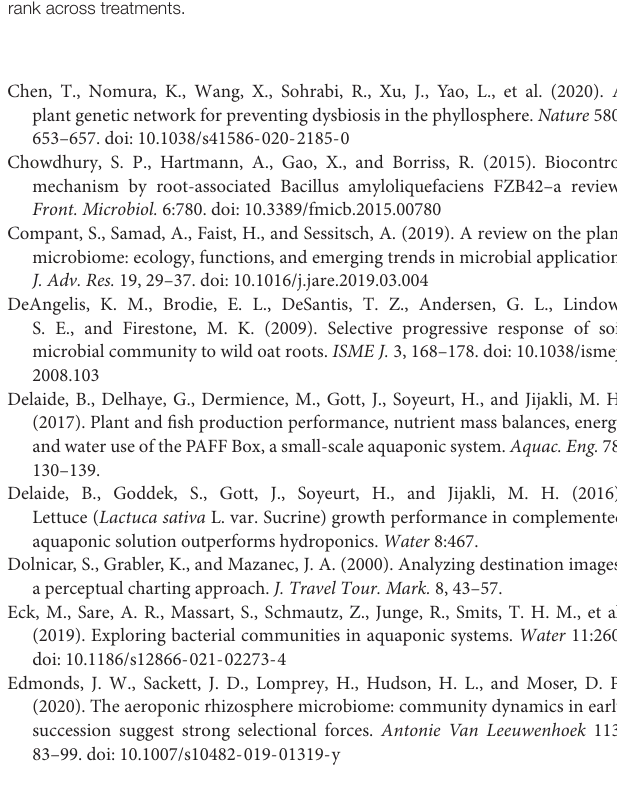
Supplementary Figure 1 | Cluster dendrogram of the distribution of microbial communities at the order rank across treatments with the five most robust clades highlighted. Similar patterns were observed at higher ranks. Treatments include hydroponic nutrient solution sump (HNS) and biofilter effluent sump (BF) under mature (.m), sterilized (.s), and basin water column (.aqueous) conditions. Additionally, soil inoculum (Soil) and HNS inoculated culture (soil) and probiotic (probio) inoculated sterilized (.s) and unsterilized biofilter effluent (BF) samples, as well as the facility water source (WS) and recirculating aquaculture system water column (RAS) are also included. Supplementary Figure 2 | Cluster dendrogram of the distribution of microbial communities at the family rank across treatments with the five most robust clades highlighted. Similar patterns were observed at higher ranks. Treatments include hydroponic nutrient solution sump (HNS) and biofilter effluent sump (BF) under mature (.m), sterilized (.s), and basin water column (.aqueous) conditions. Additionally, soil inoculum (Soil) and HNS inoculated culture (soil) and probiotic (probio) inoculated sterilized (.s) and unsterilized biofilter effluent (BF) samples, as well as the facility water source (WS) and recirculating aquaculture system water column (RAS) are also included. Supplementary Figure 3 | Distribution of phyla across treatments and controls. Supplementary Figure 4 | Co-occurrence network of microbial taxa at the order rank across